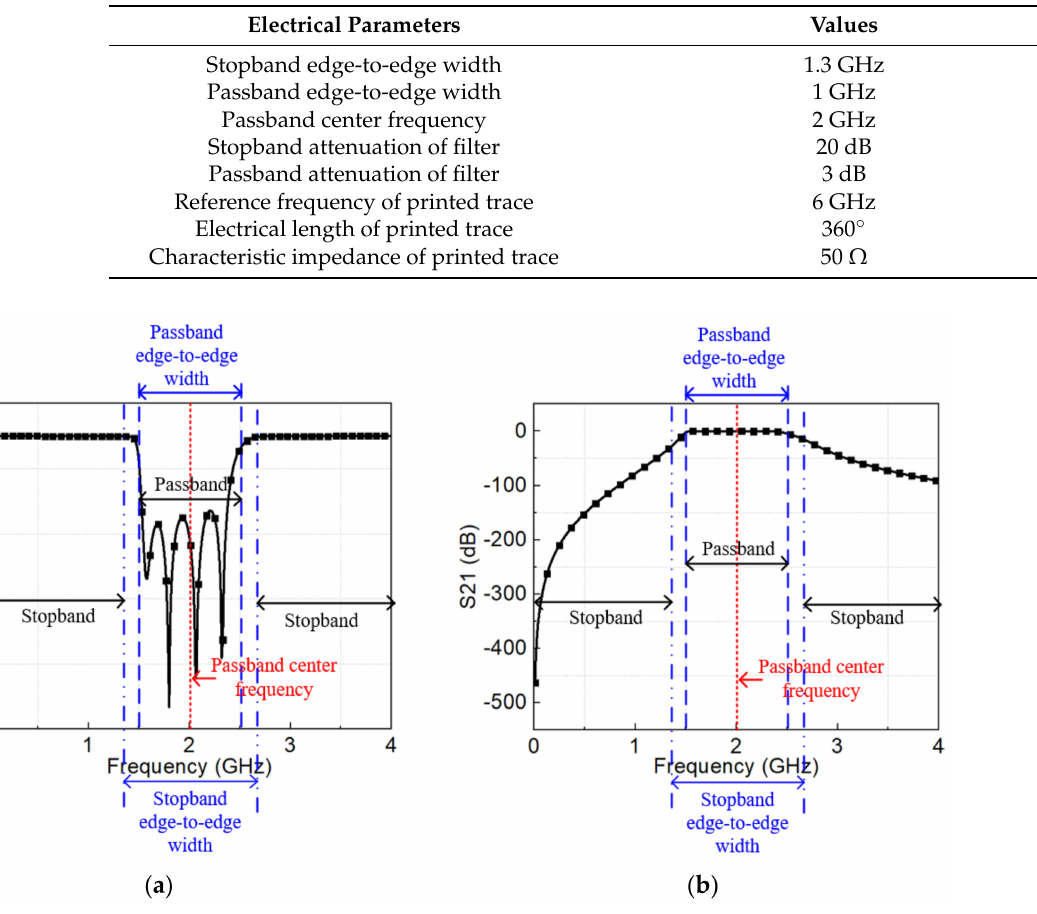
Table 1. Main electrical parameters of the example filter circuit.